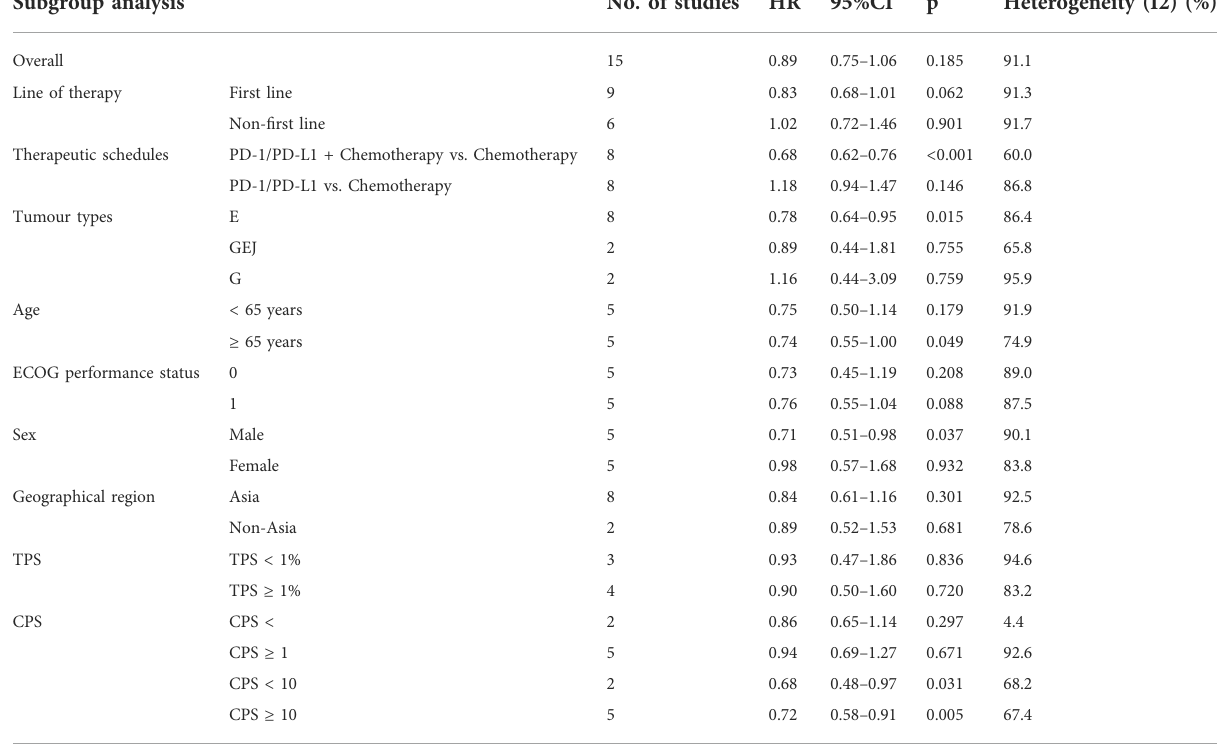
TABLE 3 Overall effects and subgroup analysis of progression-free